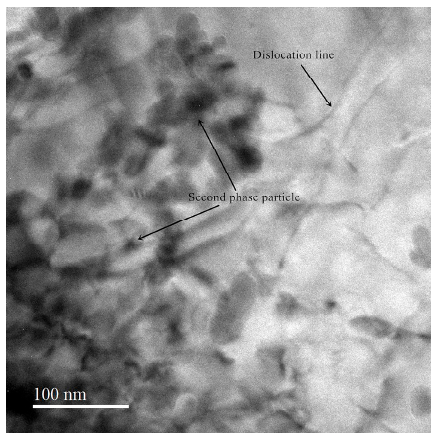
Figure 6. TEM image of ZK60 magnesium alloy heat-treated at 400 °C for 3 h + 170 °C for 24 h.